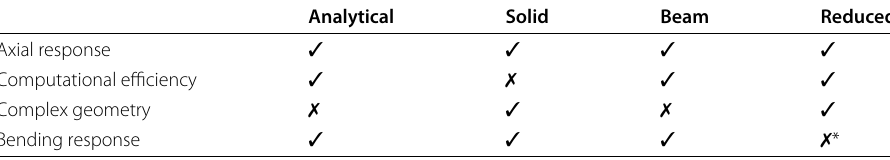
Table 1 Requirements met by each model Analytical Solid Beam Reduced ✓